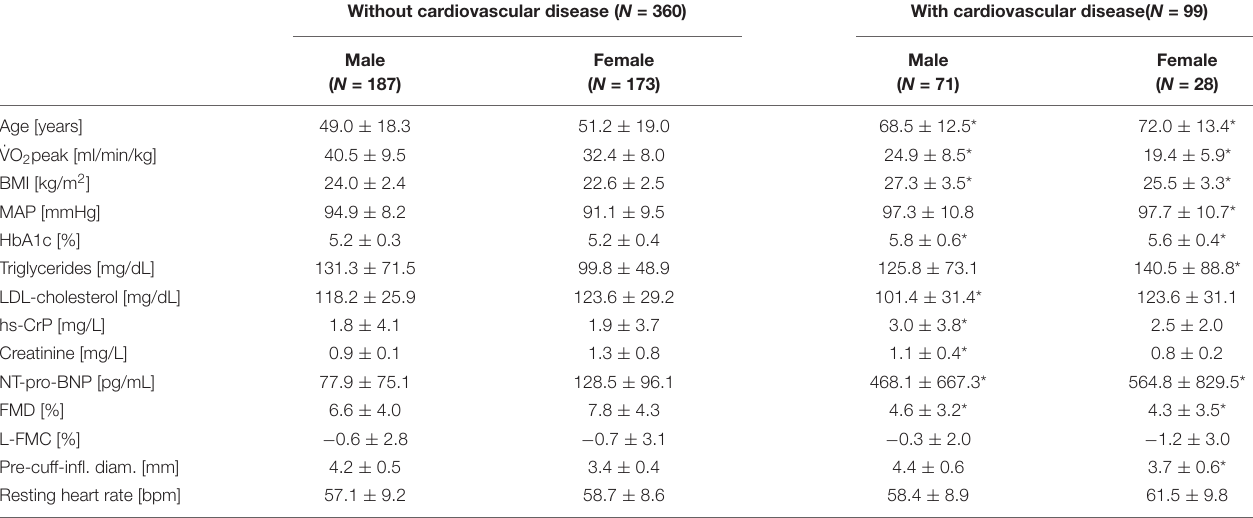
Without cardiovascular disease ( N =